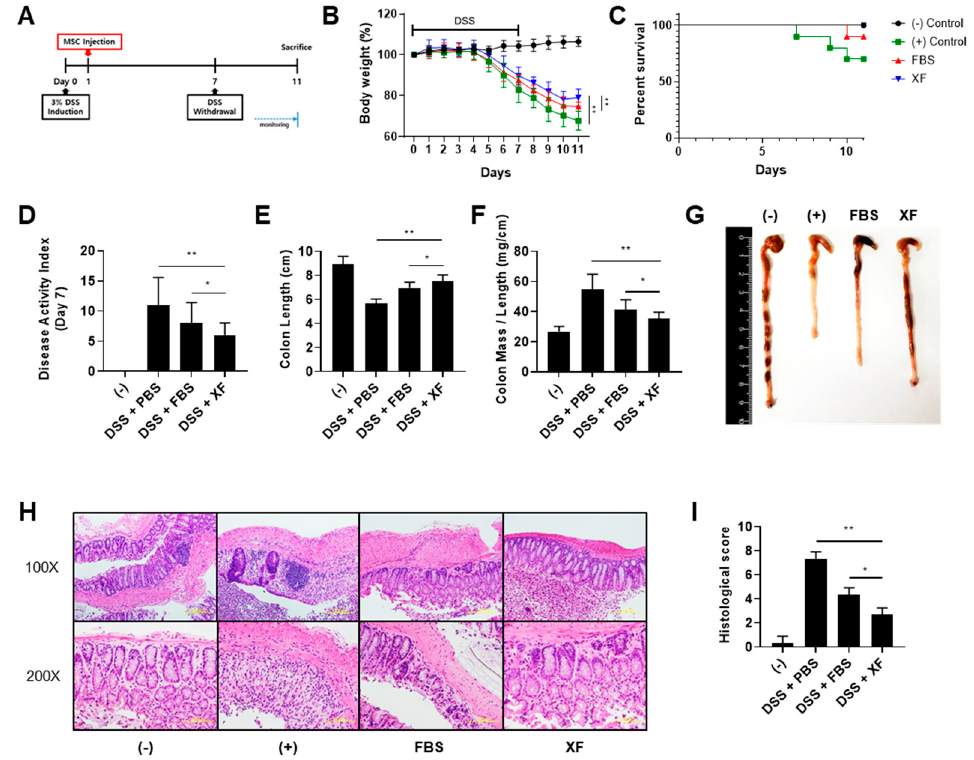
Figure 7. Administration of XF-MSCs increases the protective effects against dextran sulfate sodium (DSS)-induced colitis in mice. ( A ) Schematic presentation of experimental design. ( B ) The percentage of body weight loss and ( C ) the survival rate of mice were measured until day 11. On day 7, ( D ) disease activity index for colitis severity was measured as clinical progression. Mice were sacrificed